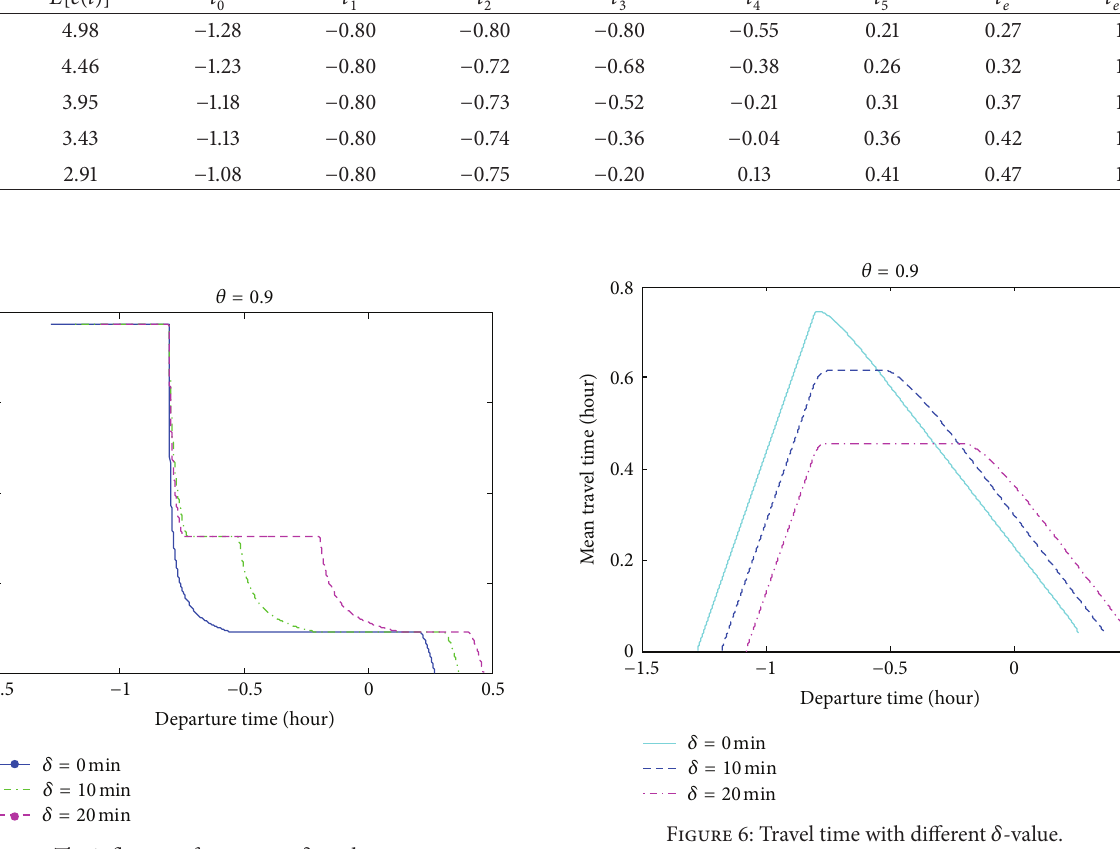
Figure 5: The influence of parameter 𝛿 on departure rate.